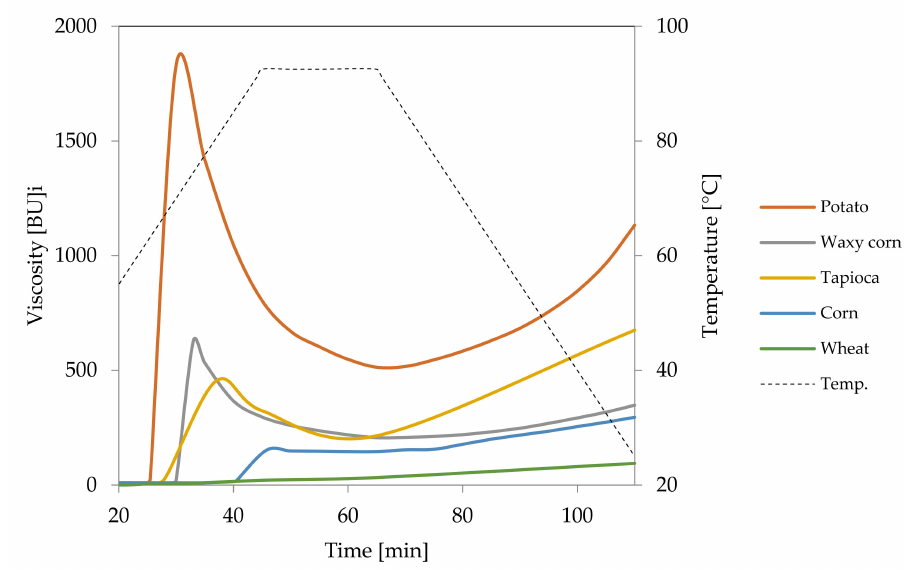
Figure 2. Pasting characteristics of native starches recorded for starch dispersions in concentration of